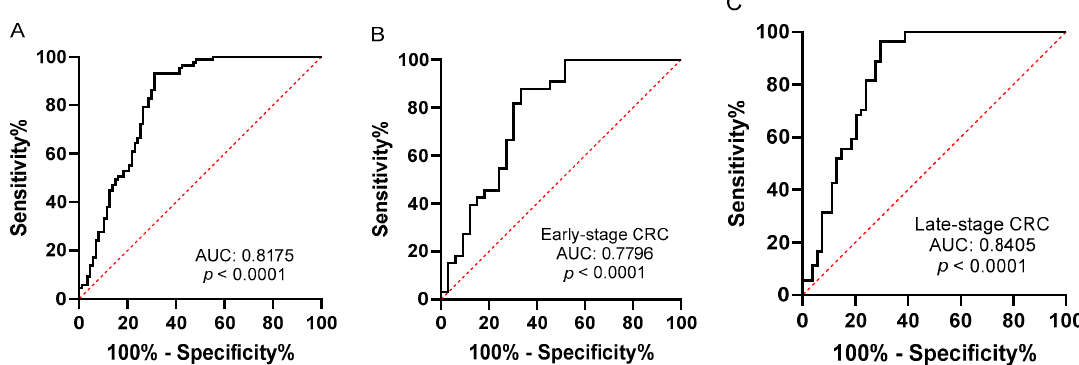
Figure 5. Assessment of the diagnostic performance of piR-24000 in CRC. A standard receiver operating characteristic (ROC) curve was plotted for piR-24000 to interpret its accuracy in discriminating CRC patients and control subjects in the following groups: ( A ) all patients combined, ( B ) early-stage CRC patients (stage I and II, n = 33), and ( C ) late-stage CRC patients (stage III and IV, n = 54).